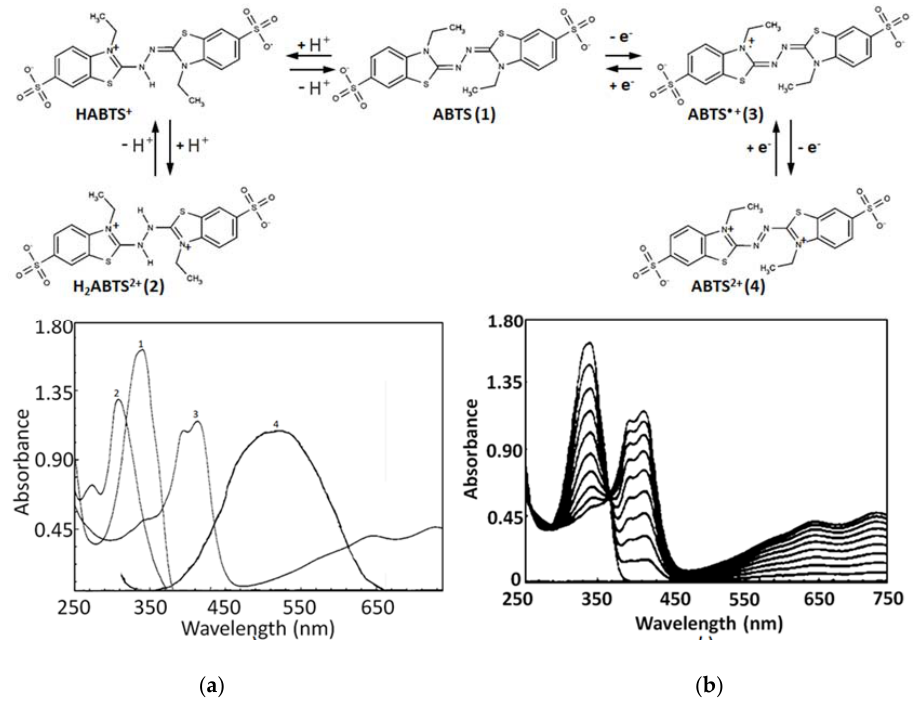
Figure 2. Structures of ABTS, the protonated and oxidized forms, and their absorption spectra in water: ( a ) ABTS pH 7 (1), ABTS pH 1 (2), ABTS •+ radical cation (3), and ABTS 2+ dication (4); ( b ) the